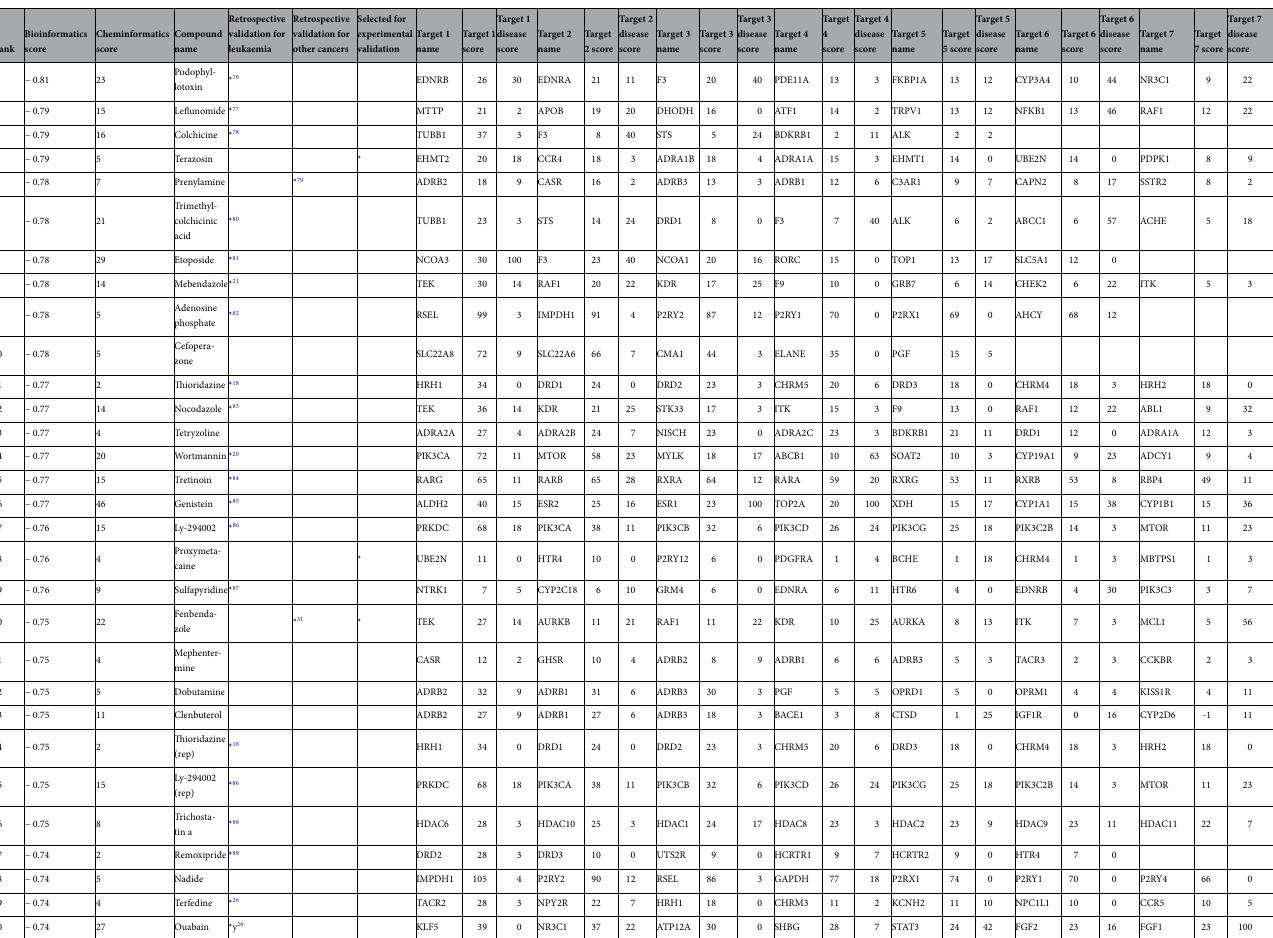
Table 1. Top 30 ranked compounds for leukaemia: the table shows the highest ranked compounds along with their predicted targets and the scores for the predicted targets (Target score). High target scores show high probability of the compound to bind to that protein target based on our in -silico prediction approach. The “Target disease score” shows how much the target is related to the disease according to Comparative Toxicogenomic Database (CTD). Compounds that have retrospective validation and literature support for leukaemia or other cancer types and the ones selected for experimental validation in this work are marked with a * for each relevant column. The Bioinformatics score is the score calculated based on anti-correlation of the compound gene signature and leukaemia differentiation signature. The Cheminformatics score is the rounded average of Target Disease Score for the top seven predicted targets of each